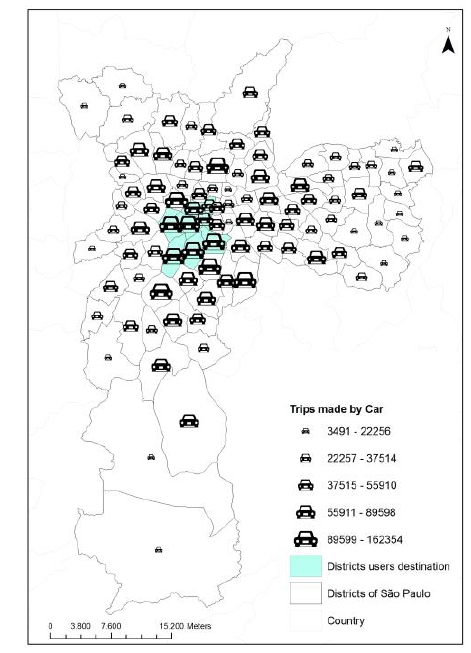
Figure 7. Number of trips: private car (Source: Authors)